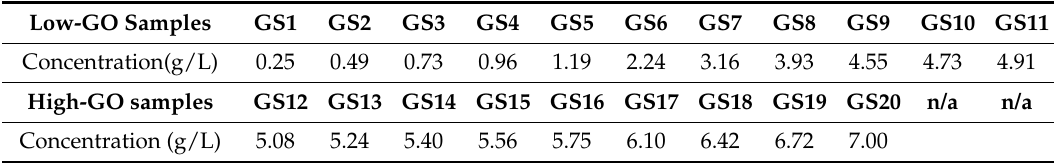
Table 1. Various GO concentration in GS samples.